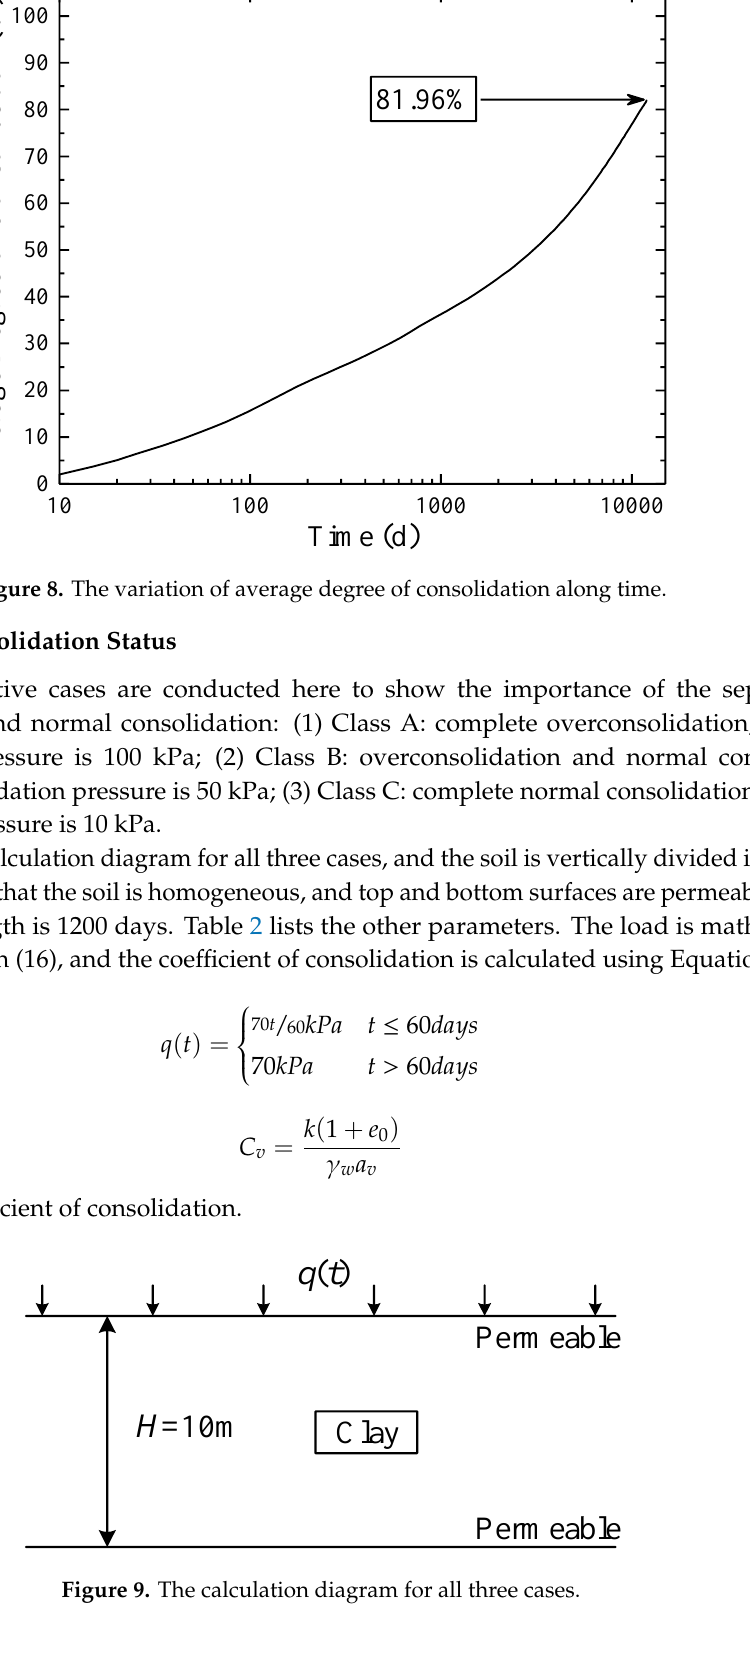
Figure 7. Comparisons of calculated and measured settlement along depth.